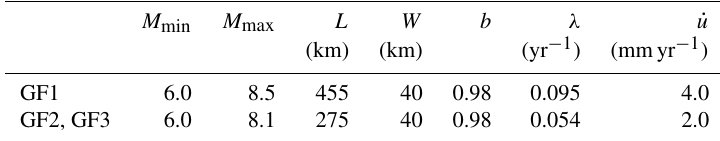
Figure 4. Comparison of the adopted synthetic catalogue generated for the GF1 section and the GR model (blue line). The catalogue values are in red. The blue circles show the corrected number of earthquakes to attain the nominal slip rate. Table 4. Summary of truncated Gutenberg–Richter laws for the active sources in the Gloria Fault